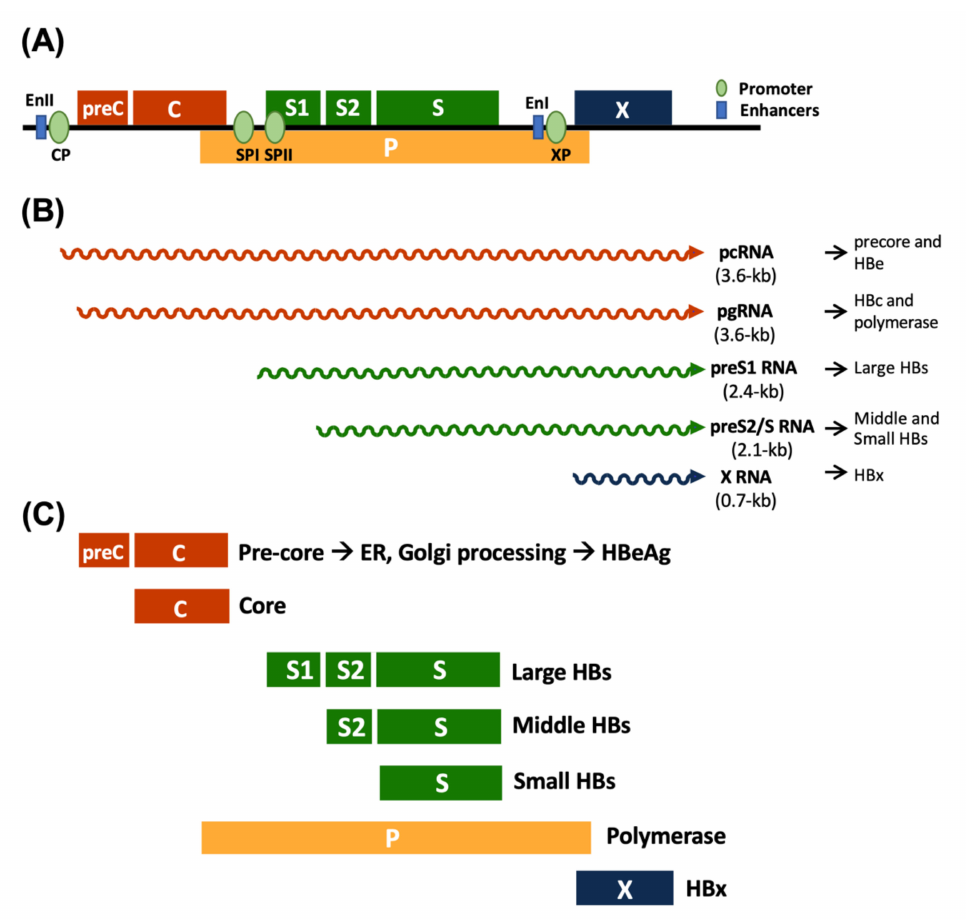
Figure 1. HBV genome, genes, transcripts, and proteins. ( A ) HBV genome organization. ( B ) Major overlapping ORFs for 3.6, 2.4, 2.1, and 0.7 kb HBV RNAs. ( C ) The ORFs encoding the HBV surface proteins (green), the multifunctional viral polymerase (yellow), the secretory HBeAg and capsid- forming core proteins (orange), and the regulatory HBx protein (dark blue) are shown. pcRNA, pre-core RNA; pgRNA, pregenomic